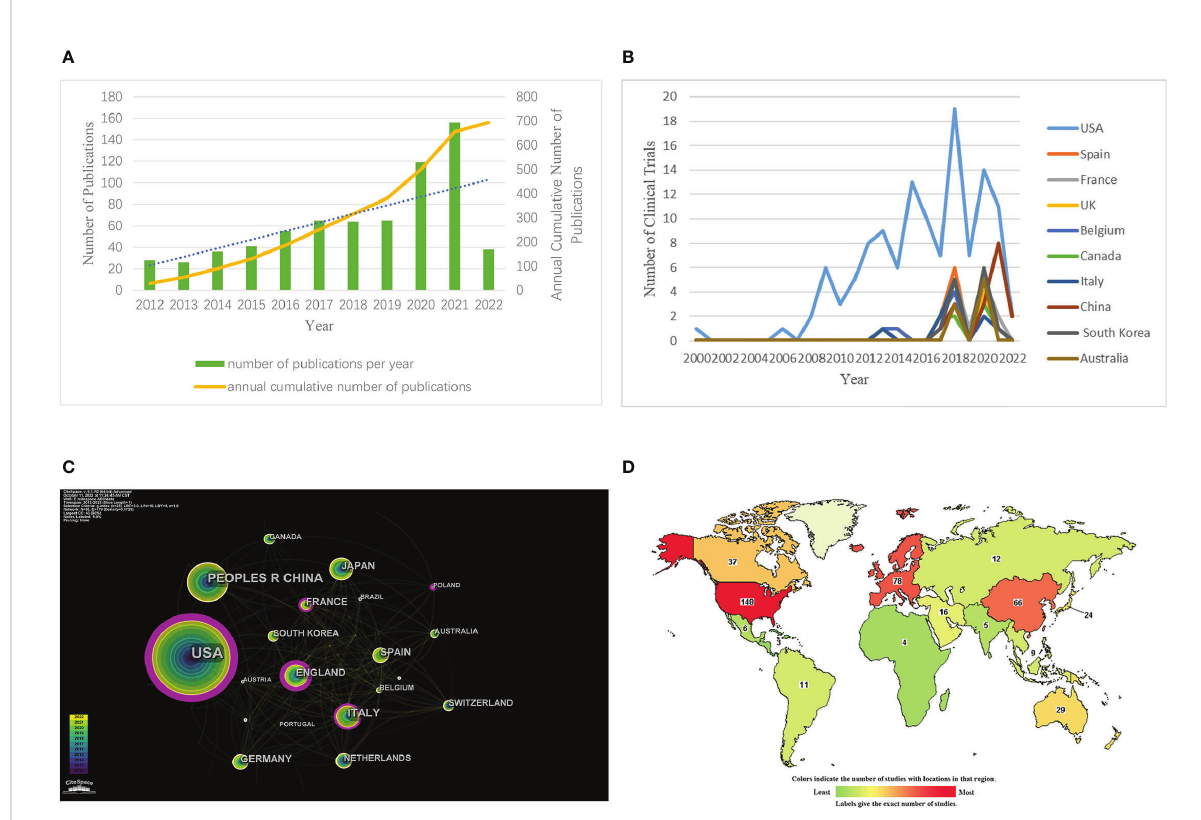
FIGURE 1 Annual growth trends and geographical distribution of ADCs. (A) The number of ADCs-related papers (as of the end of March 2022). (B) The co- occurrence map of countries/regions in ADCs research. (C) National map of clinical trials in ADCs research. (D) National ranking of clinical trials in ADCs research (https://www.clinicaltrials.gov/).